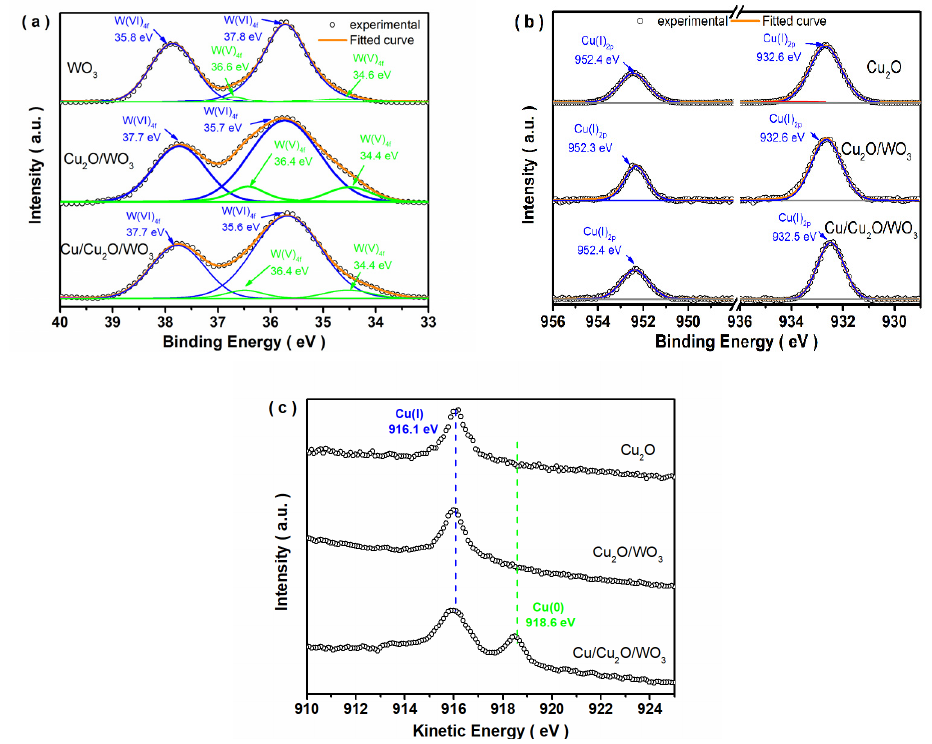
Figure 2. XPS spectra ( a ): W 4f, ( b ): Cu 2p, and Cu LMM auger spectra ( c ) of the obtained samples. The morphologies of the as-obtained WO 3 , Cu 2 O/WO 3 and Cu/Cu 2 O/WO 3 powders were visualized using SEM images. As shown in Figure 3, all the samples exhibited the typical sheet morphology with various sizes. Furthermore, the SEM image in Figure 3a